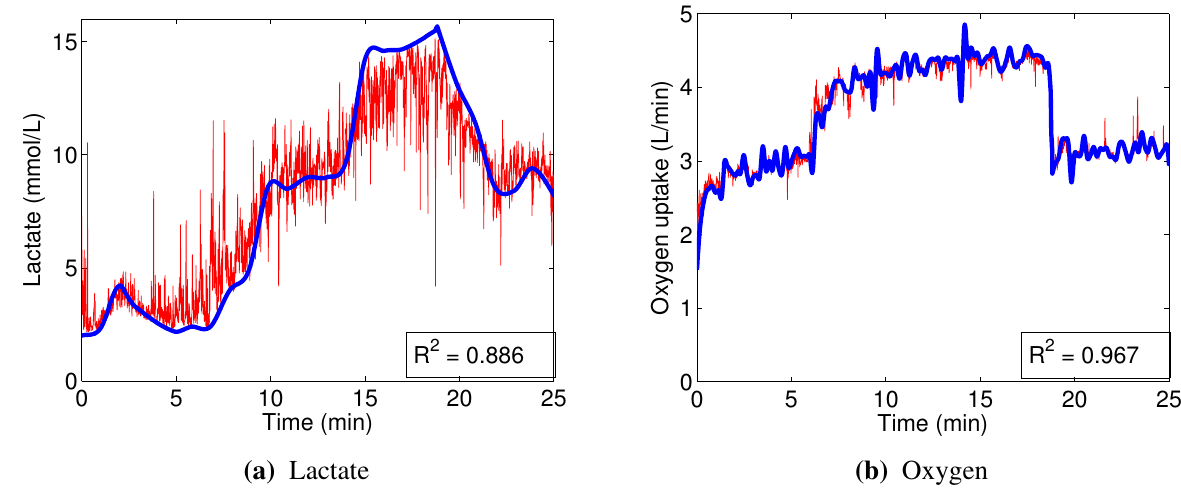
Figure 8. An example of out-of-bag predictions (red), compared to the interpolated ground truth (blue), made by the random forest regression models, built using data from right vastus lateralis of Subject